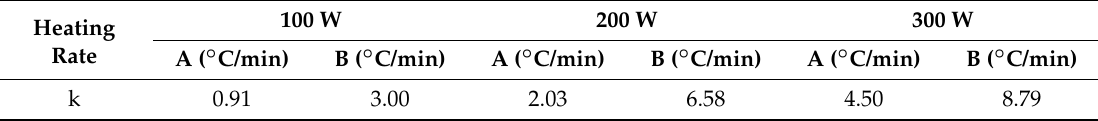
Figure 2. Curves of temperature for 20 g of oleic acid (A) and 20 g of oleic acid with 1 g of catalyst (B) at various microwave powers for different time.